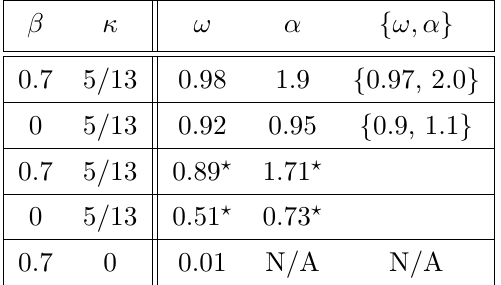
Figure 5 . Distribution of level spacings for ( L = 17 , R = 4 , S = 3) with ( β 6 = 0 , κ 6 = 0) , ( β = 0 , κ 6 = 0) and ( β 6 = 0 , κ = 0) . Right: distribution with the highest and lowest 10% of energy states removed. Left: distribution for the lowest 6% of energy states.